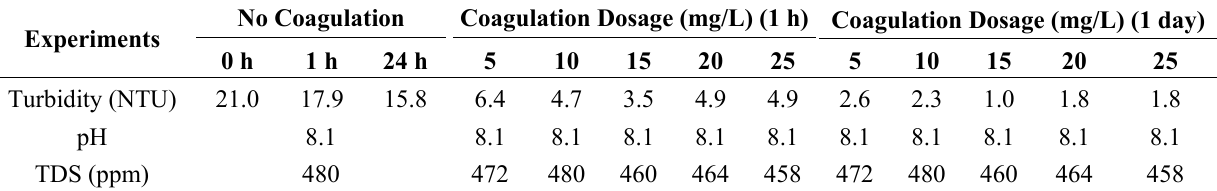
Table 3. Turbidity, pH, and total dissolved solids (TDS) values of lake water as function of Tanfloc additions after 1 h and 24 h settlements by gravity.